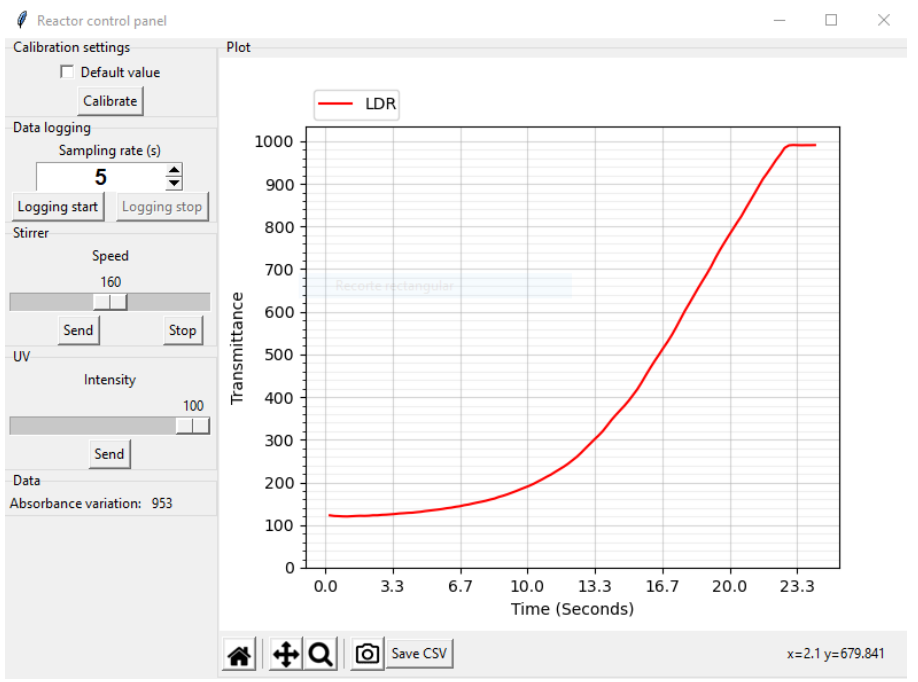
Figure 6. Screenshot of the control software.